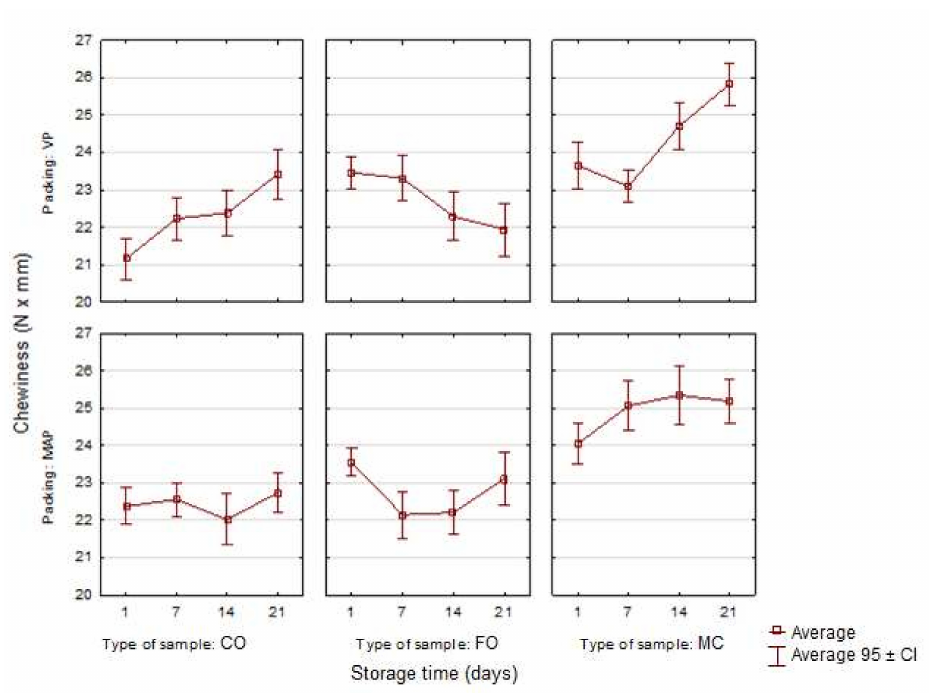
Figure 6. Changes in the chewiness in the poultry sausages depending on the type of sample, packing and storage time ( n =